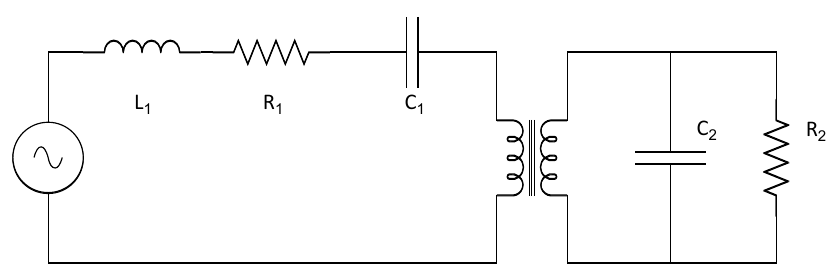
Figure 4. Butterworth Van Dyke equivalent circuit of a piezoelectric generator.